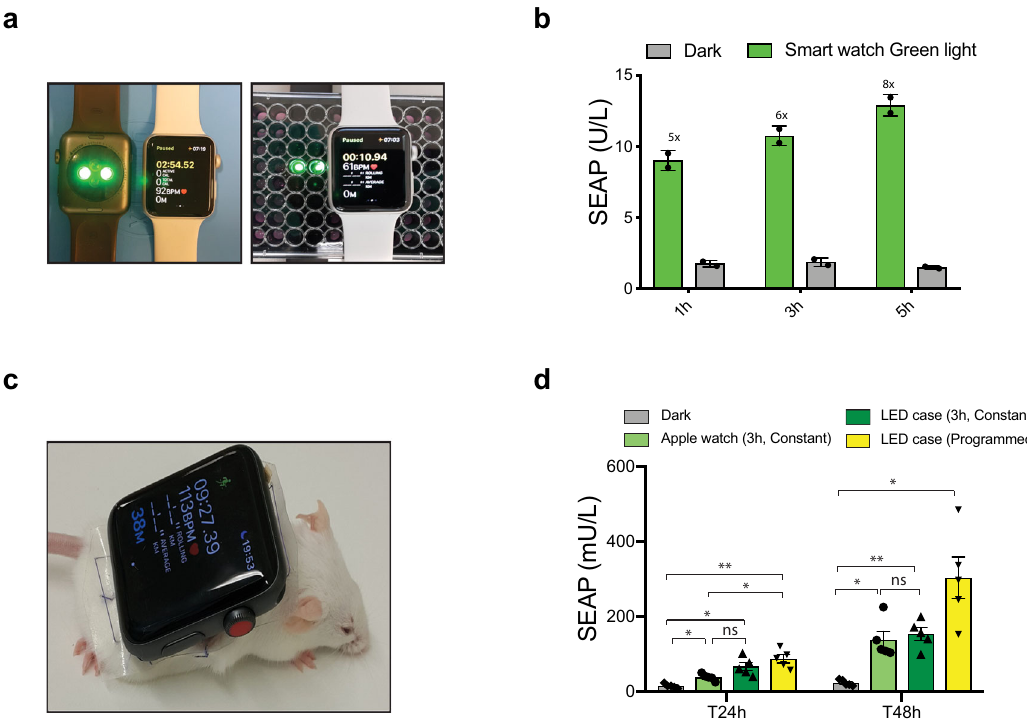
Fig. 5 Smart-watch-mediated transgene expression in vitro and in vivo. a Representative image of Apple watch-mediated in vitro gene expression. b HEK293T cells transfected with pMMZ284 (P SV40 -Myr-TtCBD-nGFP-pA), pMMZ272 (P SV40 -TtCBD-TetR-VP16-pA), and pTS1017 (P TetO7-CMVmin - SEAP-pA) were exposed to green light emitted from an Apple Watch (0.15 mW/cm 2 ) for increasing periods of time (1 h to 5 h per day). SEAP expression in cell culture supernatant was assayed at 48 h after the start of illumination. Plots show the mean ± SD of n = 2 biologically independent samples. c Representative image of RjOrl:SWISS (CD-1) mouse with an Apple Watch fi xed on its back. d RjOrl:SWISS (CD-1) mice implanted with 10 7 microencapsulated HEK293T cells (transiently co-transfected with pMMZ284/pMMZ272/pTS1017) and illuminated with green light emitted from an Apple Watch (3 h, constant, 150 μ W/cm 2 ) or a light-weight custom-built LED patch (either 3 h constant or pulsed for 12 h/day, 15 s ON/45 s OFF, 150 μ W/cm 2 ). SEAP levels in the blood were measured for 2 days. Experimental groups are indicated above the plot and values are mean ± SEM ( n = 5). Statistical signi fi cance between indicated groups were calculated using a one-way ANOVA. ns, not signi fi cant; * p < 0.05; ** p < 0.01. Source data are provided as a Source Data fi